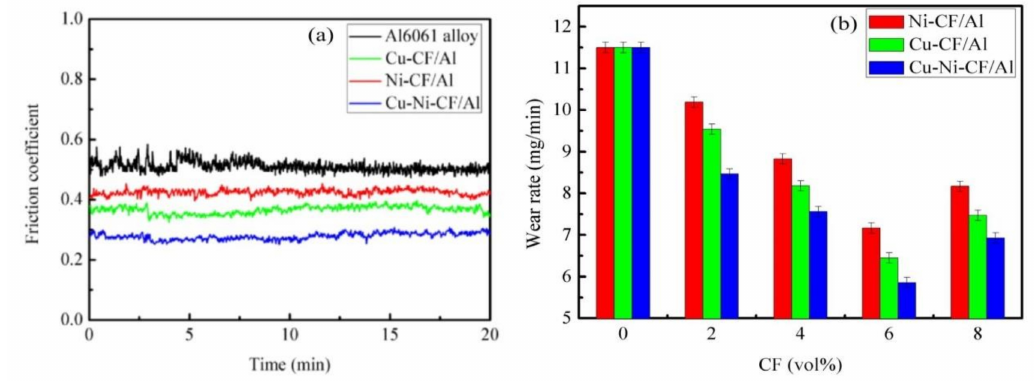
( a ) The friction coe ffi cient of Cf / Al6061 alloy composites with di ff erent coatings. ( b ) The diagram of wear rate and fiber content of di ff erent composite